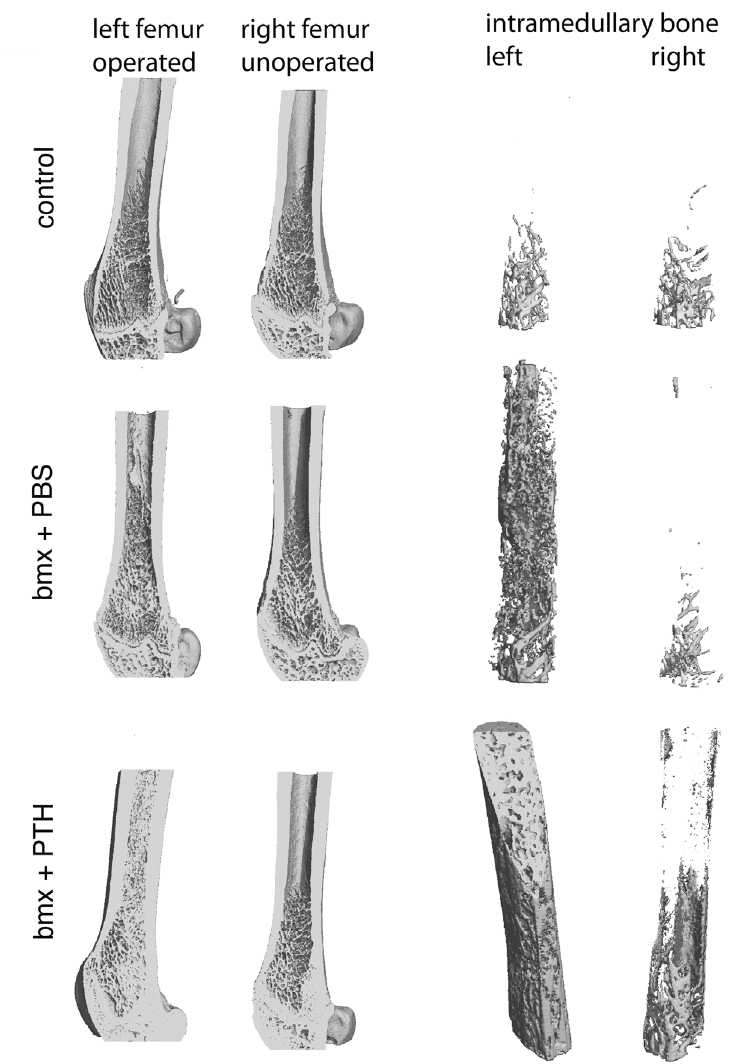
Figure 2. MicroCT analysis of femoral shafts of left operated and right unoperated femurs from control and bone marrow-ablated (bmx) rats treated five days per week with PBS or with PTH for 28 days. The images on the right were generated by “peeling off” the cortical bone to isolate the intramedullary bone. Note the abundance of bone present in lieu of marrow in the ablated femoral shaft from rats treated with PTH.